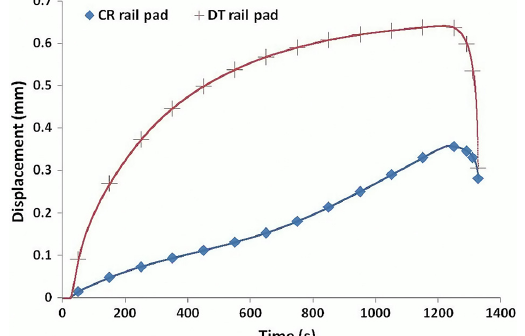
Fig. 4. Time-displacement curves measured in the static test at loads of 20−95